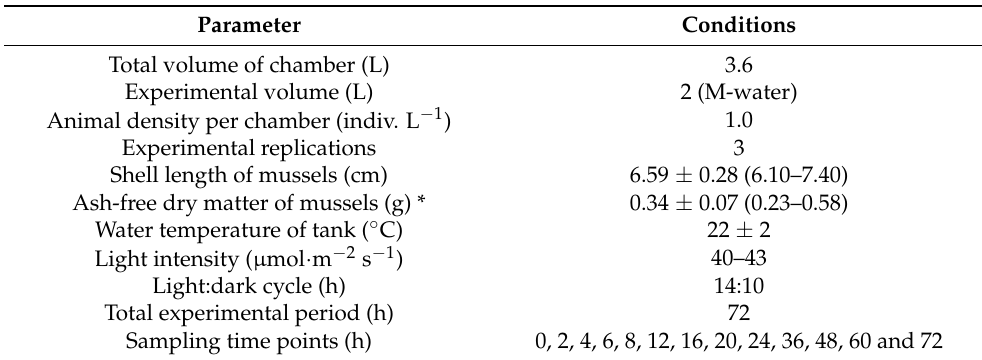
Table 1. Experimental conditions for the study of the freshwater bivalve Unio douglasiae Griffith et Pidgeon in Microcystis -rich waters. Parameter Conditions Total volume of chamber (L) 3.6 Experimental volume (L) 2 (M-water) Animal density per chamber (indiv. L − 1 ) 1.0 Experimental replications 3 Shell length of mussels (cm) 6.59 ± 0.28 (6.10–7.40) Ash-free dry matter of mussels (g)